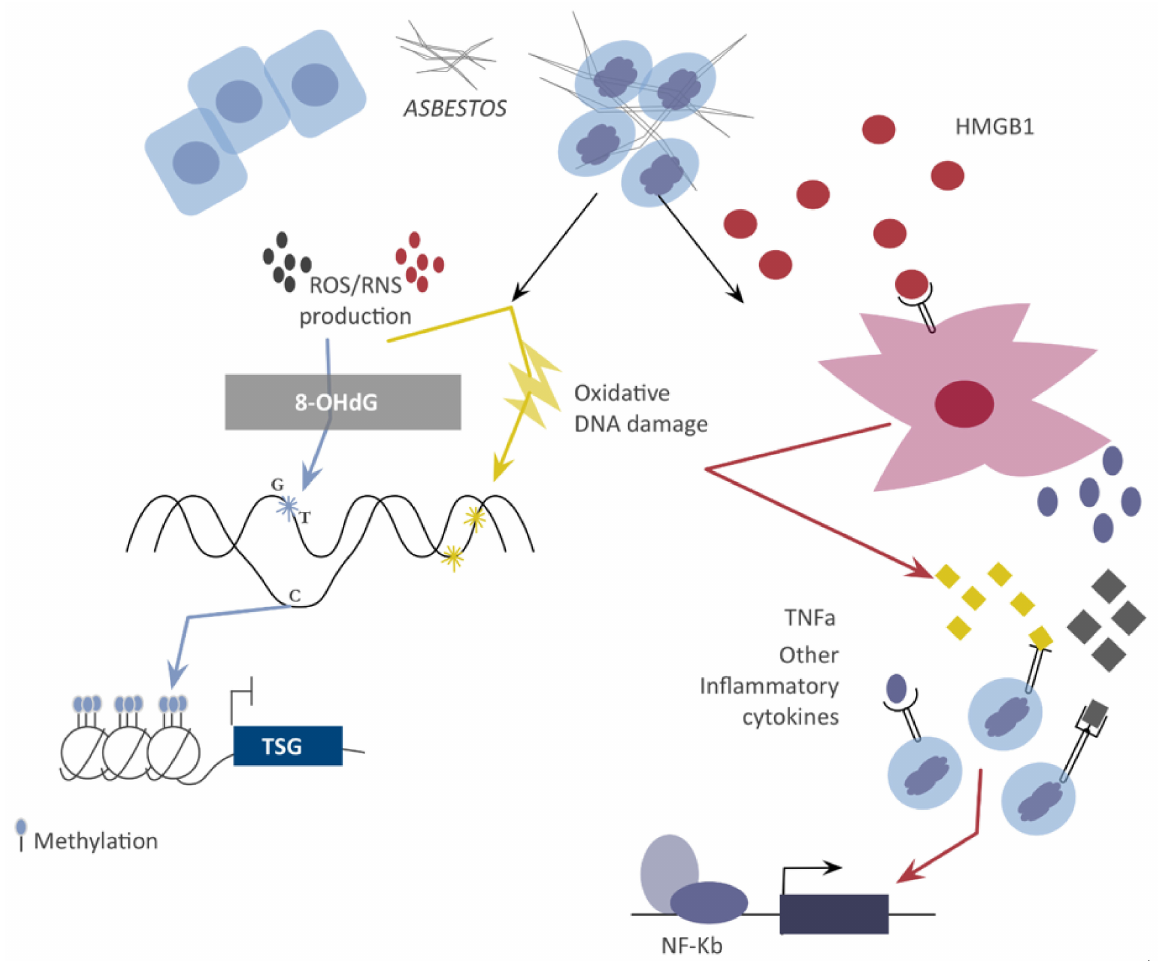
Figure 1. Inhalation of asbestos fibers causes an inflammatory response in the lungs that results in the chronic production of ROS and RNS. These reactive species collide with biological molecules, damaging them. In particular, 8-OhdG can generate DNA base mispairing, resulting in G-to-T transversions. Moreover, DNA methylation is vulnerable to asbestos fibers that, indeed, are a cause of tumor suppressor genes (TSGs), promoting hypermethylation and subsequent silencing. Additionally, mesothelial cells exposed to asbestos undergo necrosis, releasing HMGB1 into the intercellular space and thus recruiting macrophages and stimulating the chronic inflammation response. Activated macrophages release TNF-alpha and other inflammatory cytokines that result in NF-kB. Activation leads to consequent survival of HM cells with genetic damage. These two mechanisms work together to trigger tumor formation and growth. List of abbreviations: ROS—reactive oxygen species, RNS—reactive nitrogen species, TSGs—tumor suppressor genes, HMGB1—high-mobility group box 1, TNFa—tumor necrosis factor